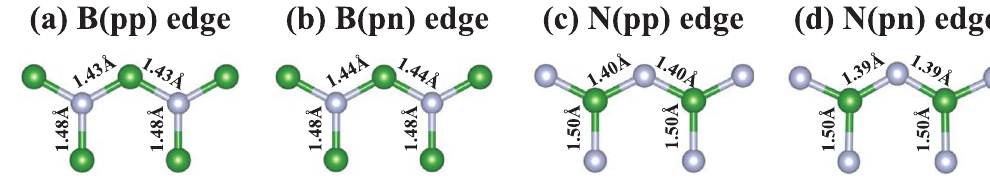
Figure 4. Bonding profile at the edges for different spin configurations.